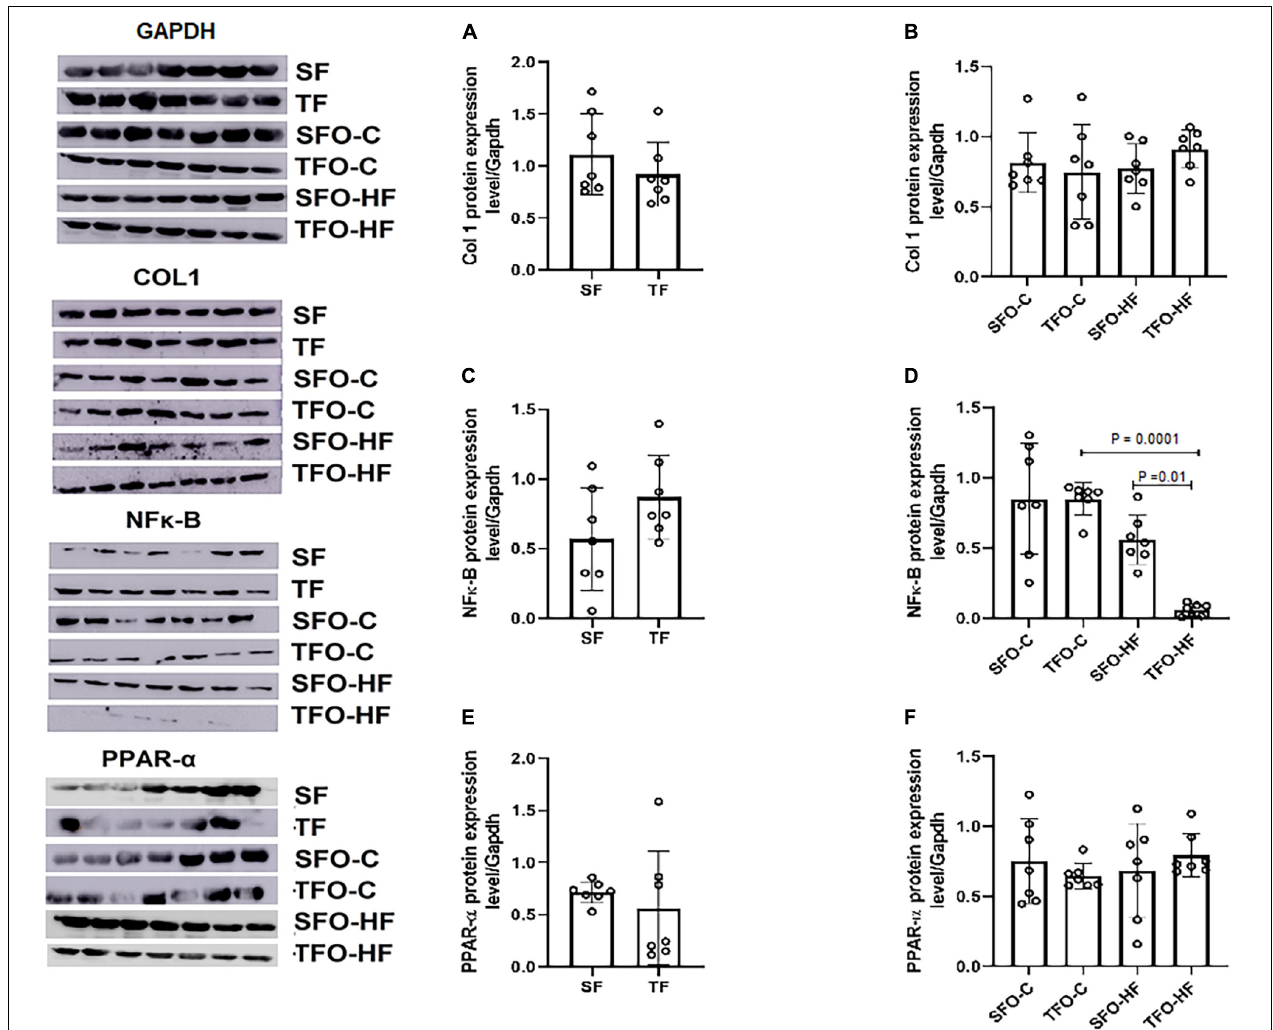
FIGURE 7 | Collagen type I, NF- κ B, and PPAR- α protein expression in the gastrocnemius muscle of fathers and offspring exposed to control diet and HFD. The data are mean ± standard deviation. (A) Col 1 protein expression level/Gapdh in the fathers. (B) Col 1 protein expression level/Gapdh in the offspring. (C) NF- κ B protein expression level/Gapdh in the fathers. (D) NF- κ B protein expression level/Gapdh in the offspring. (E) PPAR- α protein expression level/Gapdh in the fathers. (F) PPAR- α protein expression level/Gapdh in the offspring. SF, sedentary fathers; TF, trained fathers; SFO-C, offspring from sedentary fathers, exposed to